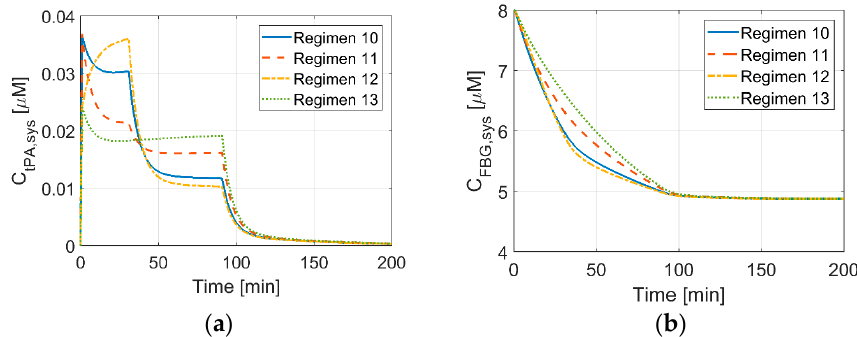
Figure 7. Concentrations of tPA ( a ) and FBG ( b )over time for the new regimens simulated in this study.